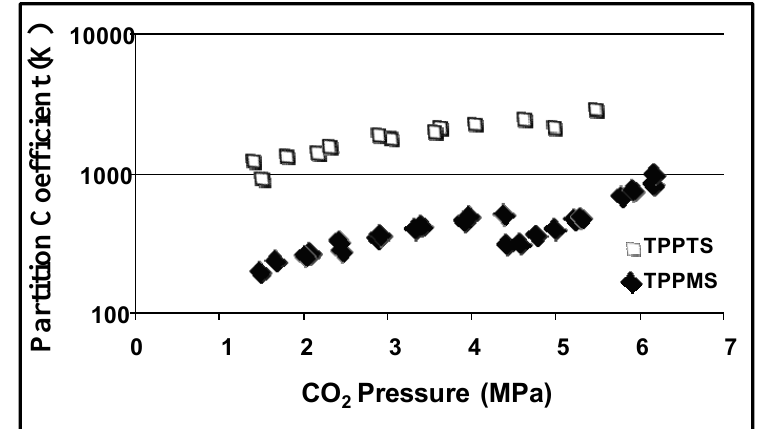
Figure 5. Partitioning of hydrophobic 1-octene and nonanal in the CO phase as a function of CO